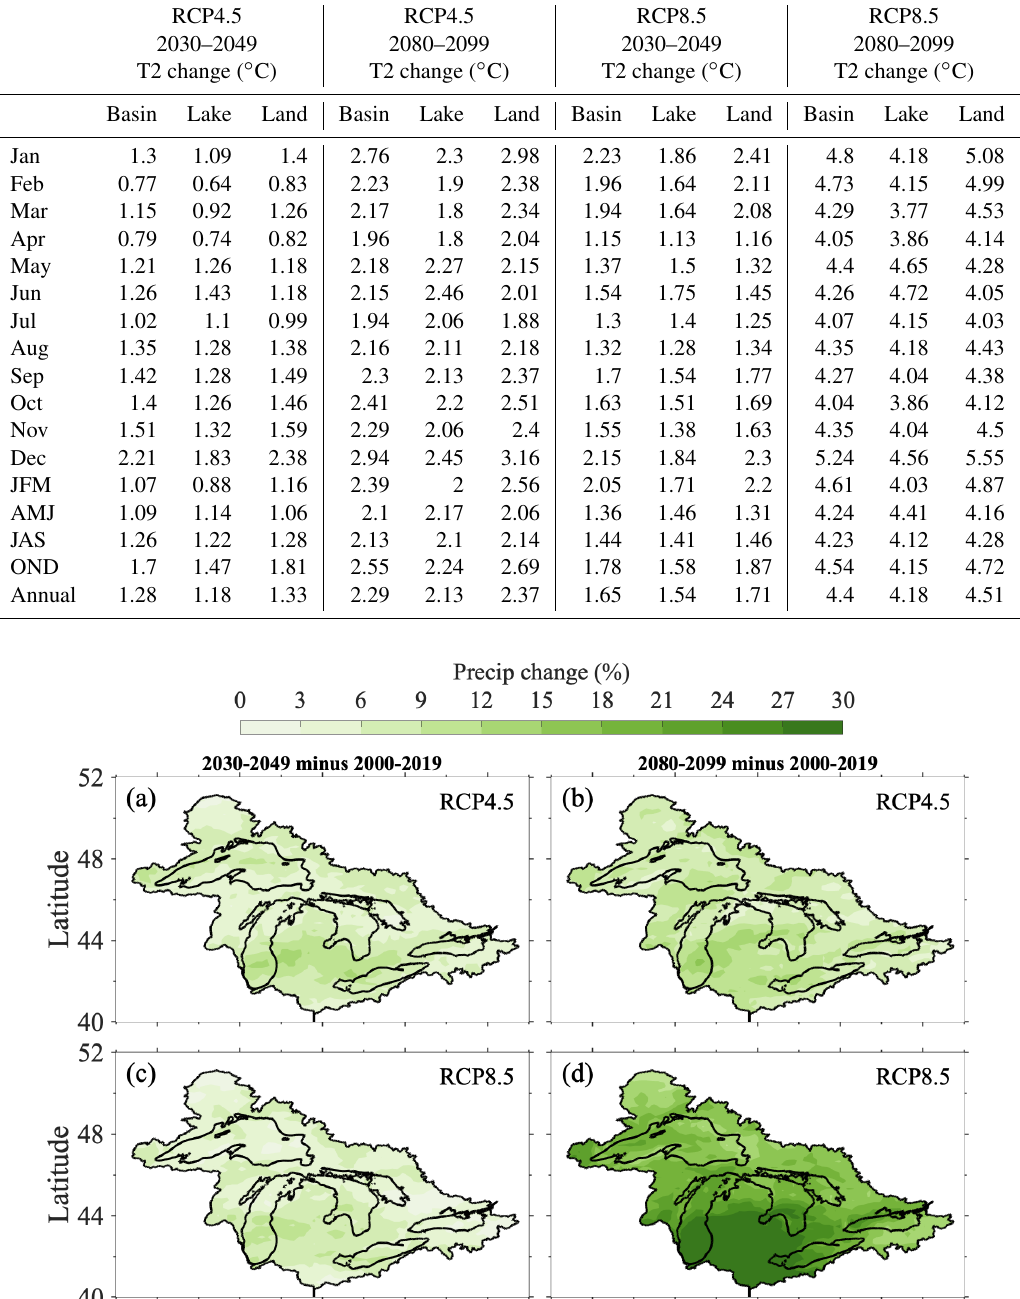
Table 3. GLARM-EA3 projected changes in monthly, seasonal, and annual surface air temperature over land, lake, and the Great Lakes basin in the mid-century (2030–2049) and late century (2080–2099) for the RCP 4.5 and RCP 8.5 scenarios, relative to the present-day climate (2000–2019).